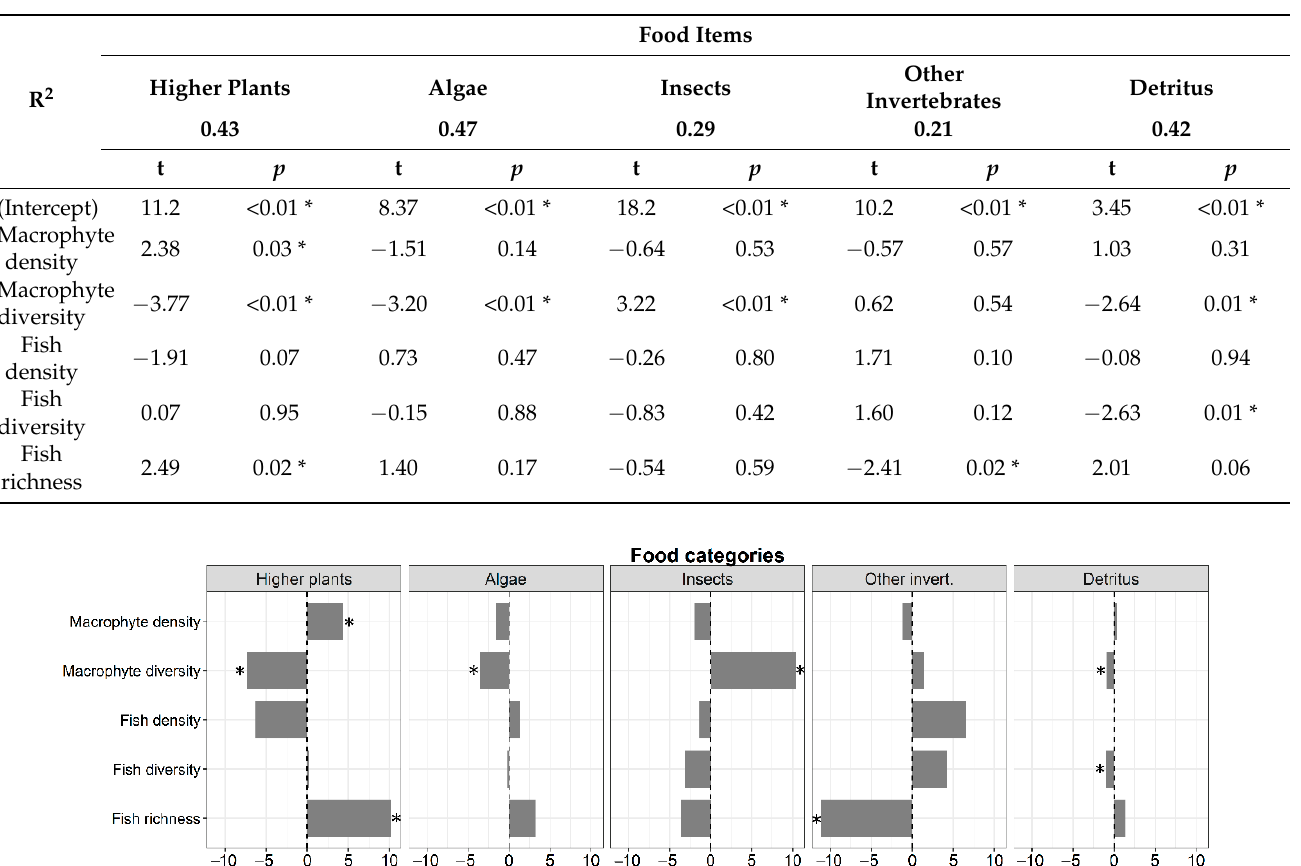
Table 2. Results of generalized linear models for the consumption of five food categories. * = statistically significant values.